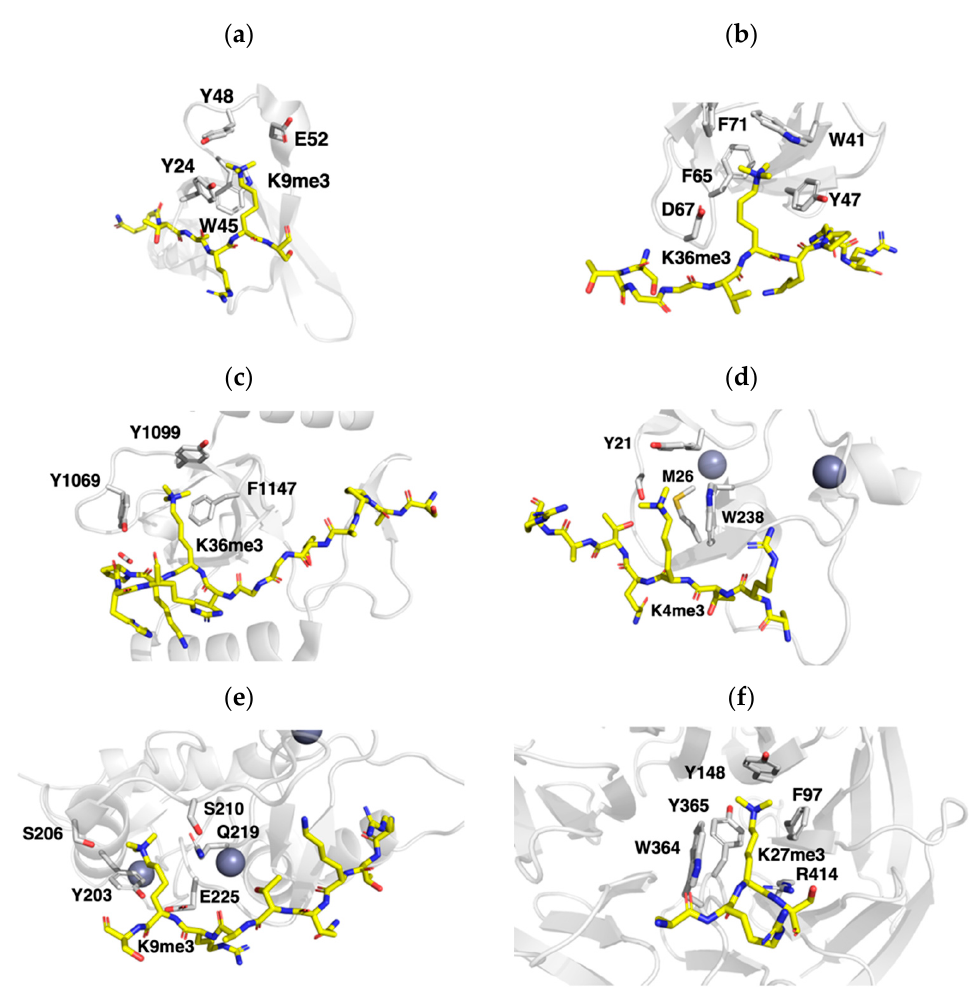
Figure 15. Ribbon representations of Kme3 readers (grey) in complex with histone 3 peptides (yellow) in stick representation. Key residues for Kme3 recognition are labeled and zinc ions are depicted as spheres. ( a ) HP1 CD (PDB-ID: 1KNE) [138], ( b ) PHF1 TD (PDB-ID: 4HCZ) [139], ( c ) BRPF1 PWWP (PDB-ID: 2X4W) [140], ( d ) ING2 PHD (PDB-ID: 2G6Q) [141], ( e ) ATRX ADD (PDB-ID: 3QL9) [142], ( f ) EED WD40 (PDB-ID: 3JZG) [143].